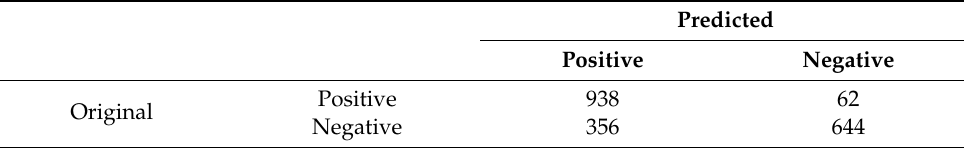
Table 15. Confusion matrix for ontology with level importance approach.